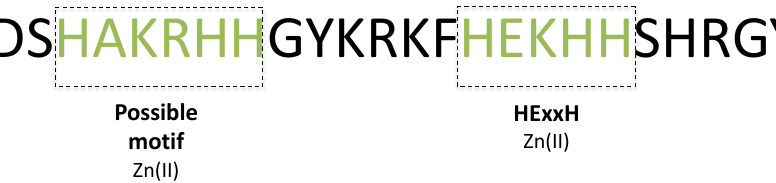
Figure 1. Primary structure of Hst5 with two of the zinc-binding motifs highlighted. The suggested possible zinc binding motif will be further discussed in the results